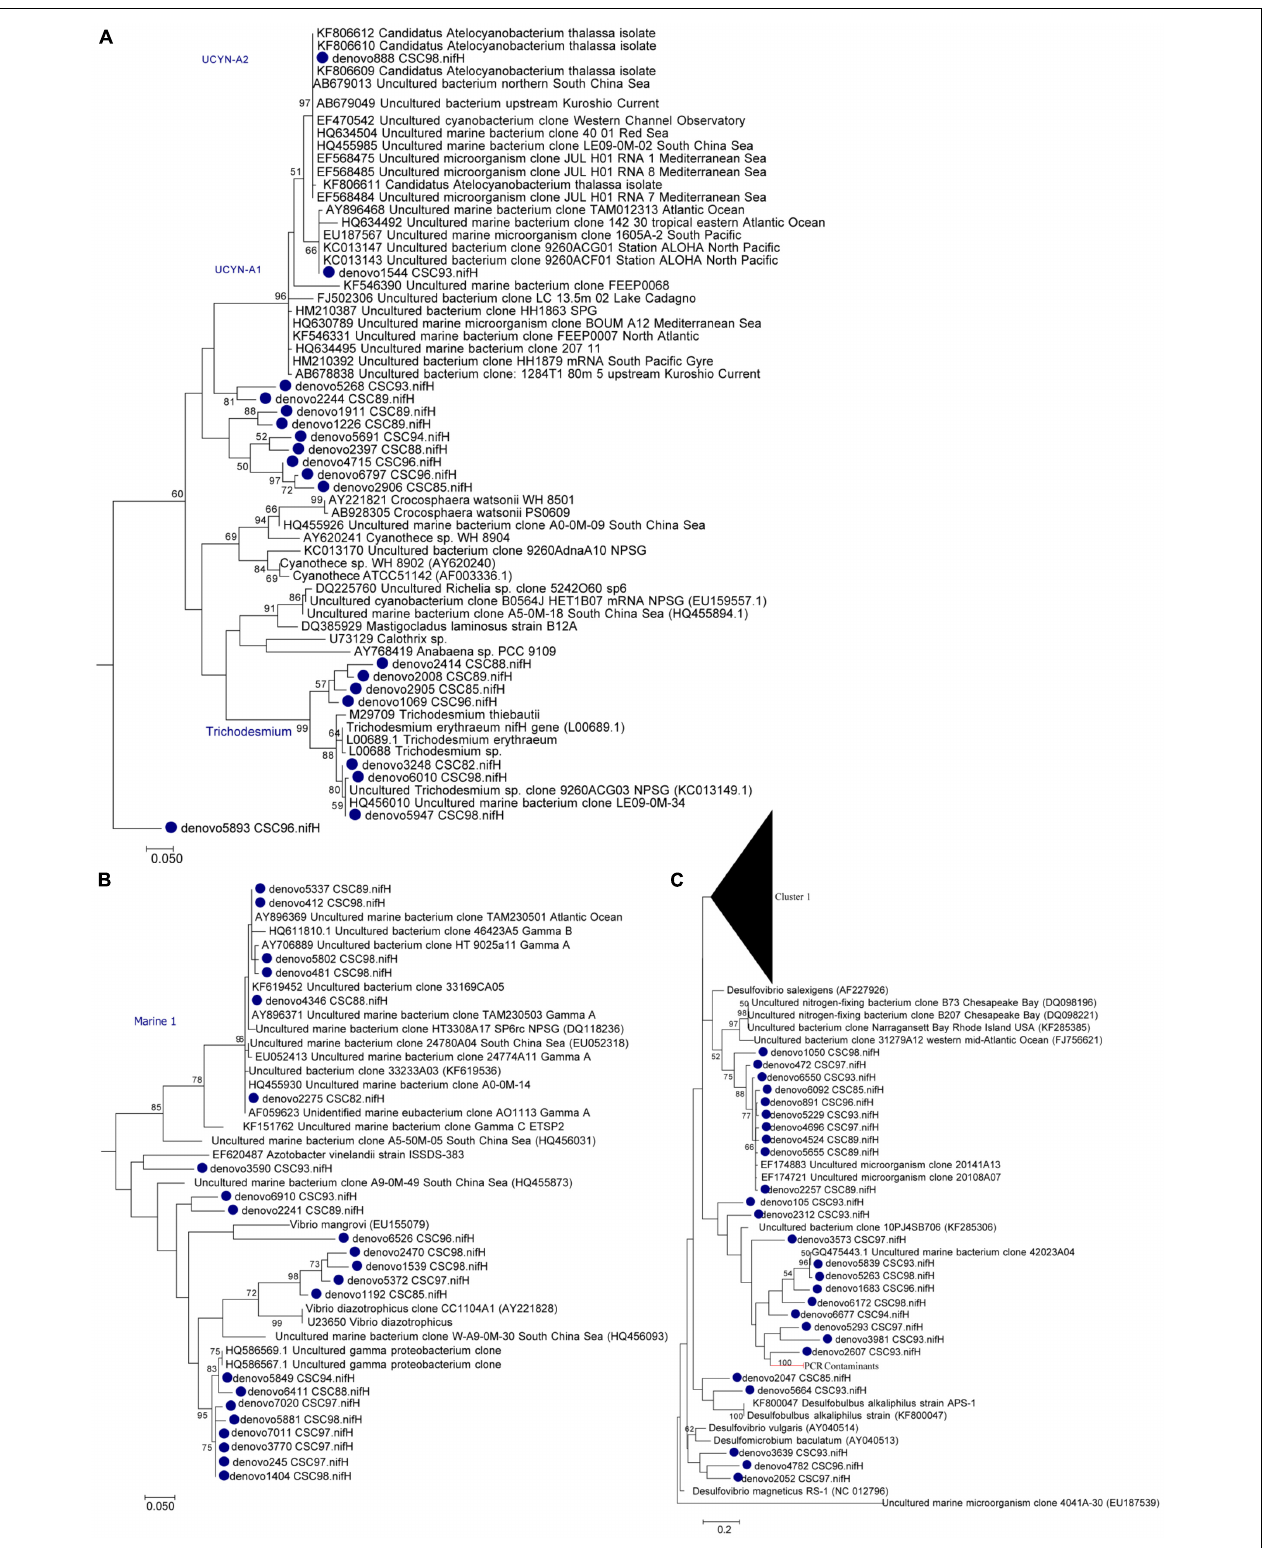
FIGURE 5 | Maximum likelihood phylogenetic subtree of (A) Cluster IB Cyanobacteria, (B) Cluster IG Proteobacteria, and (C) Cluster III nifH OTUs (clustered at 97% nucleotide identity). Bootstrap support ≥ 50% is shown for 1000 bootstraps. Please refer to Supplementary Figure 2 for the full nifH phylogenetic tree.